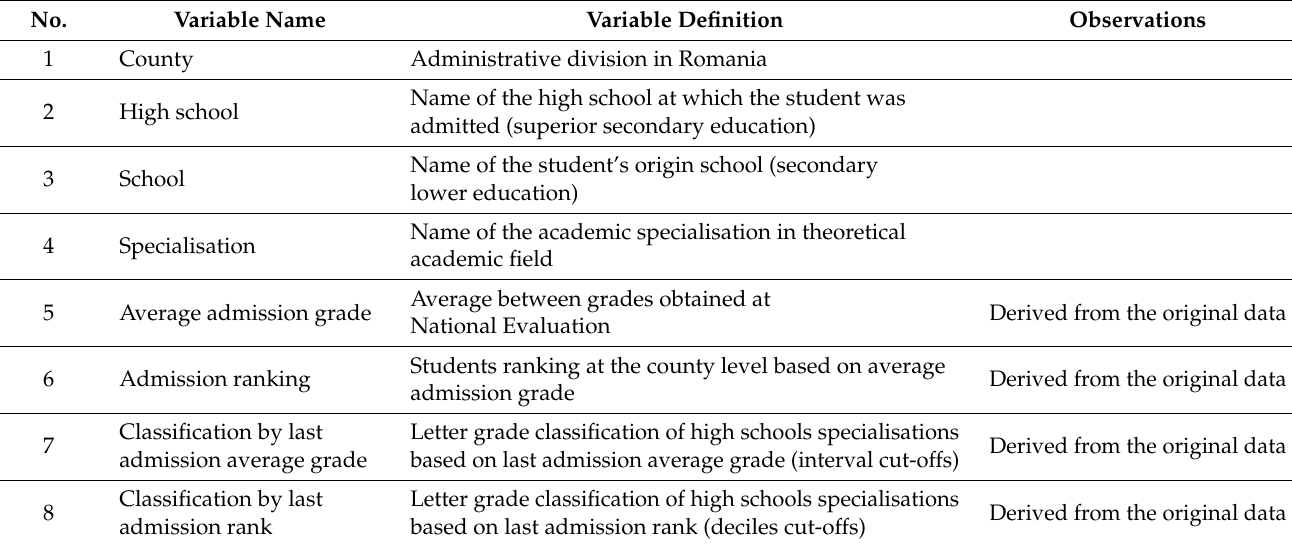
Table 2. Variables